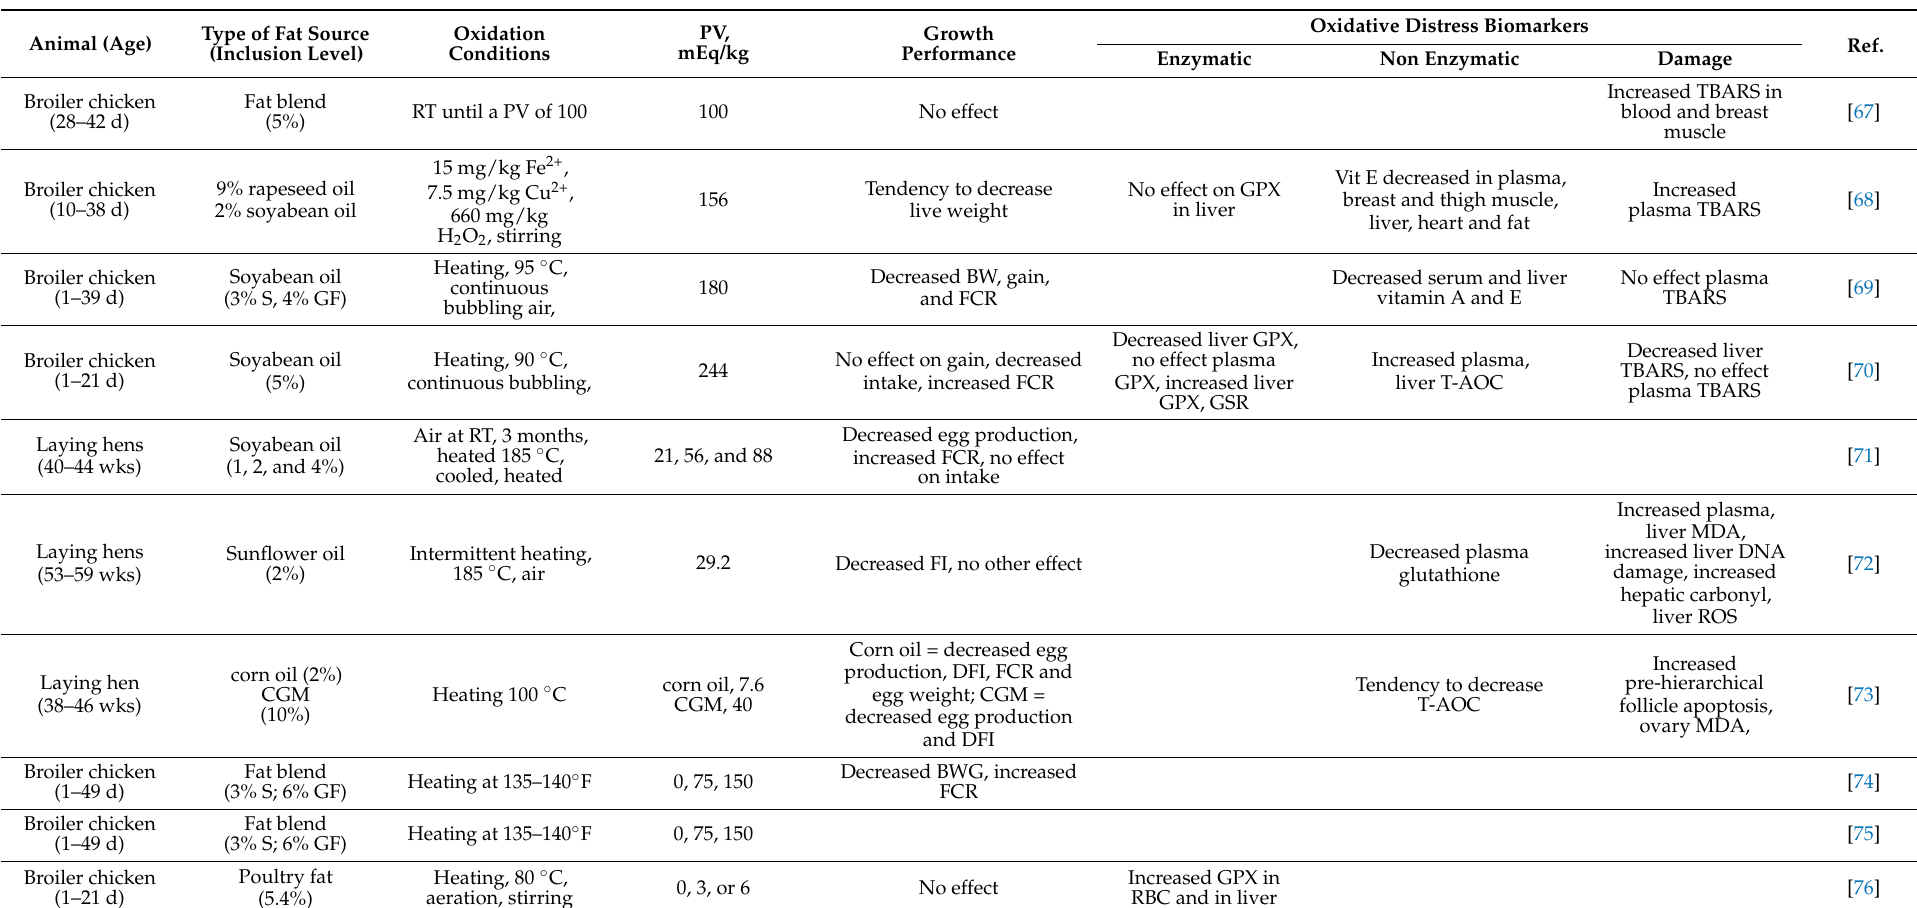
Table 1. Summary of the dietary oxidative stress challenges models using oxidized fat in poultry, including type of fat, oxidation conditions, resultant fat characterization and inclusion level in feed, and results including growth performance impact, oxidative stress markers evaluated classified by enzymatic, non-enzymatic or oxidative